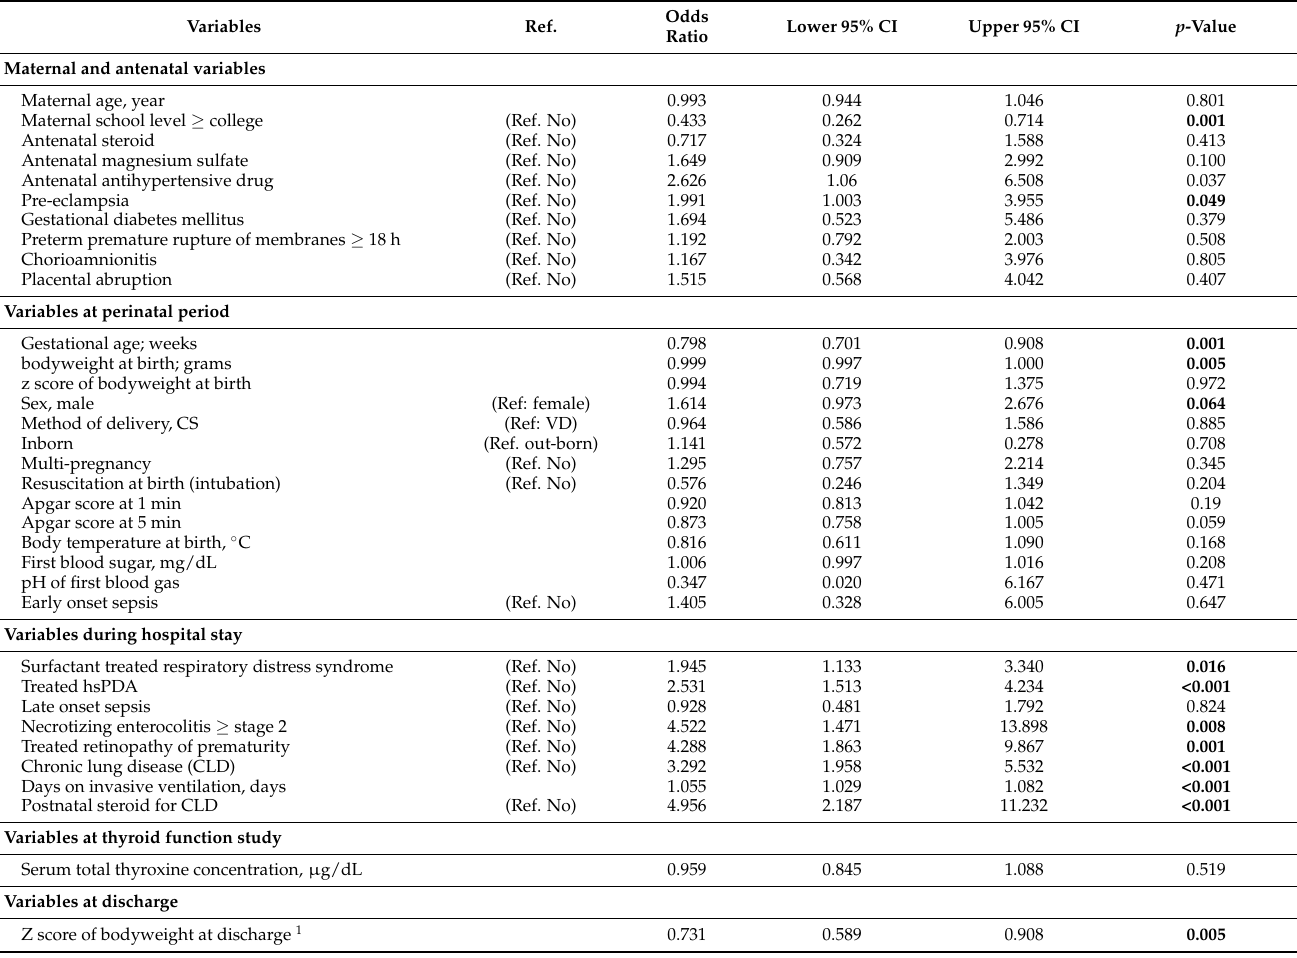
Table 2. Dependence of neurodevelopmental impairment on clinical variables: univariate analysis.